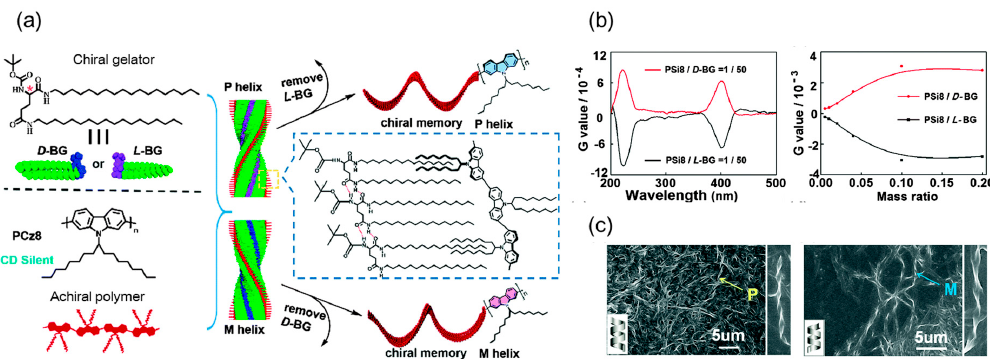
Figure 3. ( a ) Illustration of chiral transfer from gelator to achiral polymer. ( b ) CD spectra of the supramolecular chiral co-gels. ( c ) SEM images of the helical fibers. (Reproduced from [79] with permission from The Royal Society of Chemistry).